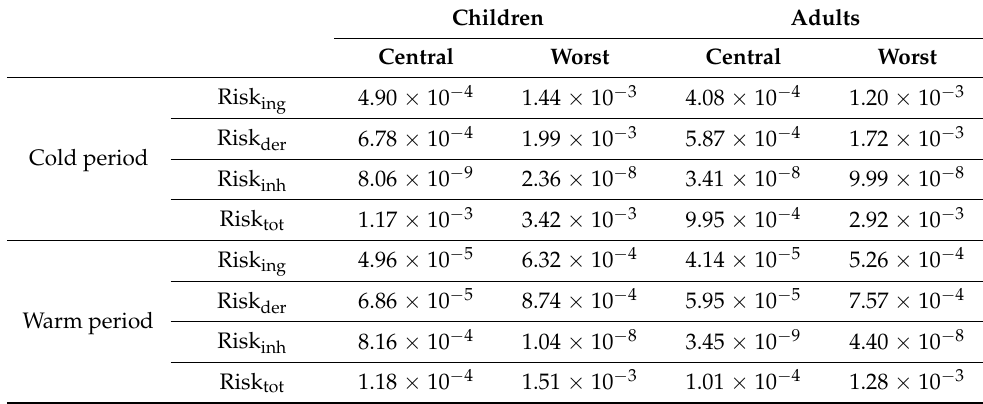
Table 3. Cancer risk for exposure routes of inhalation, ingestion and dermal absorption from PAHs in PM 10 . Children Adults Central